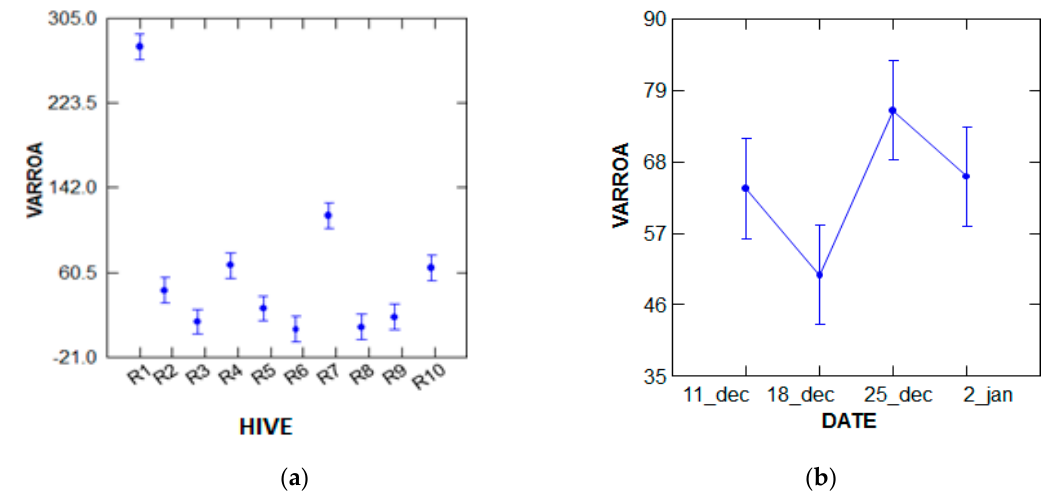
Figure 3. Analysis of the variance of the number of dead varroa by treatment. ( a ) Hive; ( b ) Date.